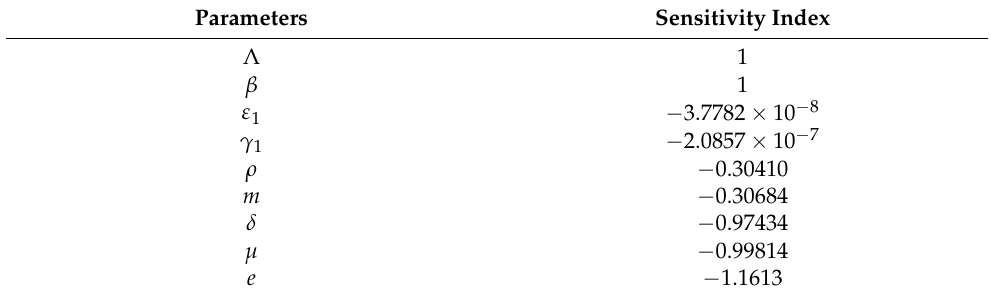
Table 3. Sensitivity indices of R 0 for each parameter using the estimated values detailed in Section 3.2.